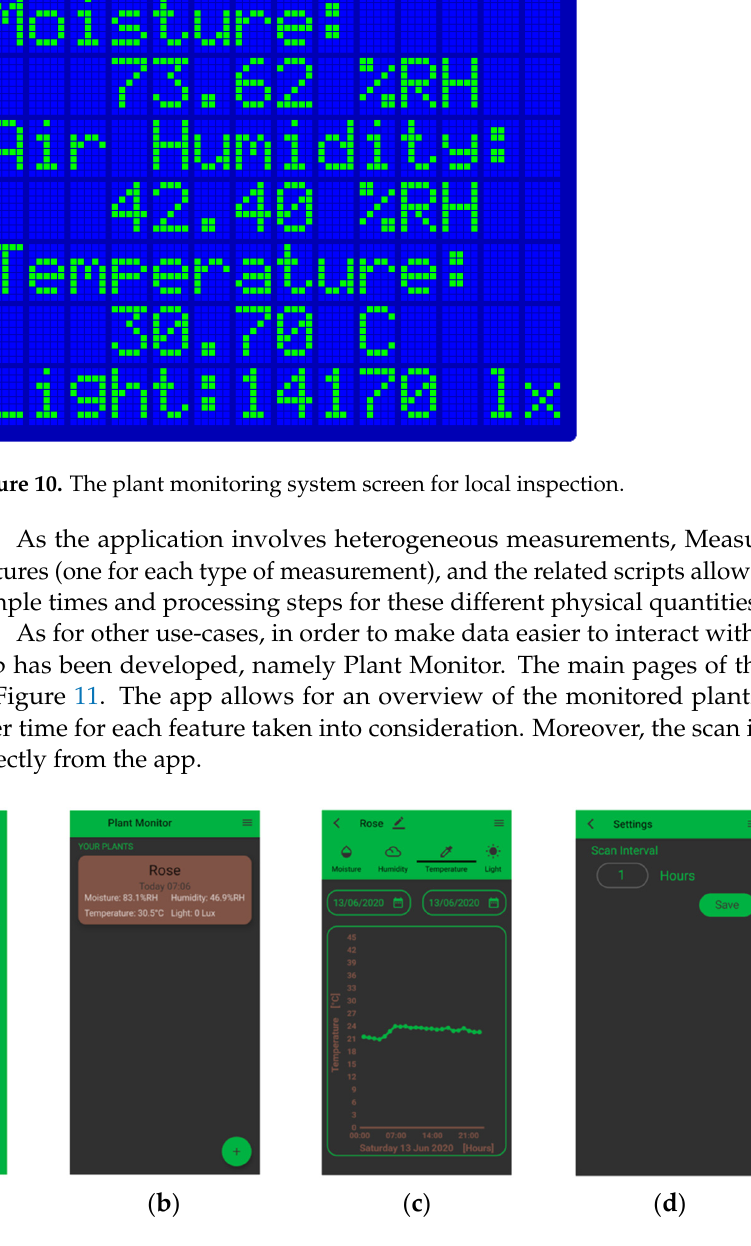
Figure 11. The plant monitoring app: ( a ) login page; ( b ) report on the monitored plants; ( c ) temper- ature graph over time; ( d ) scan interval settings.